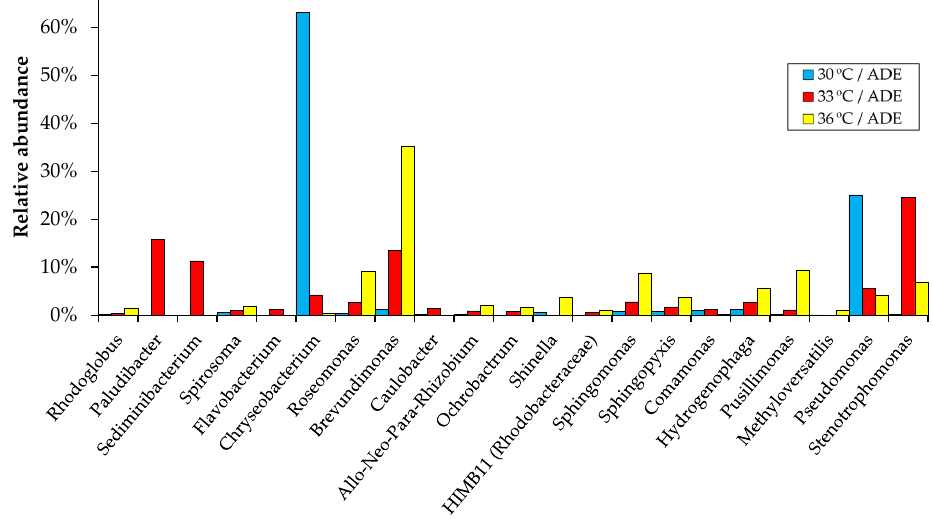
Figure 8. Relative abundance of bacterial genera (based on 16S rRNA gene) detected during C. sorokiniana AM-02 cultivation in ADE-containing media (184 h).